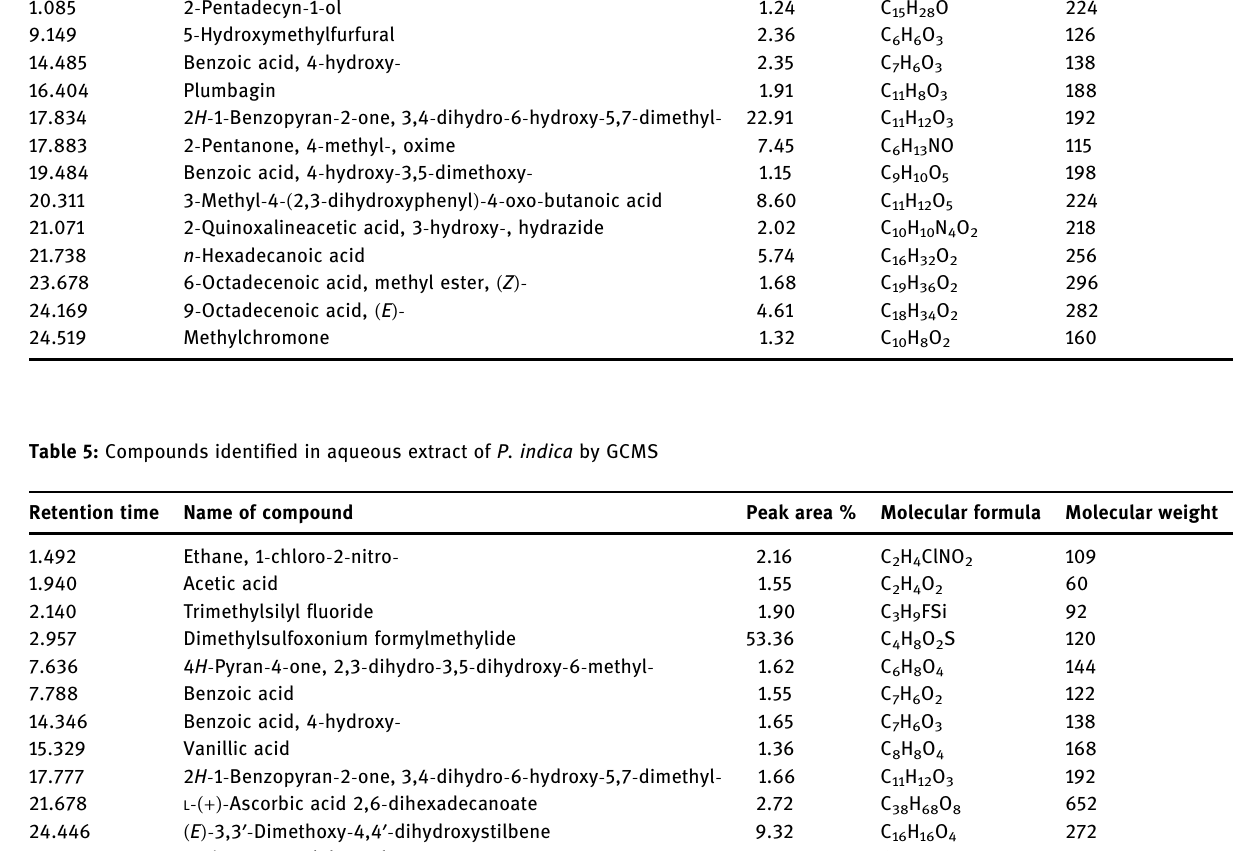
Table 4: Compounds identi fi ed in methanolic extract of P. indica by GCMS Retention time Name of compound